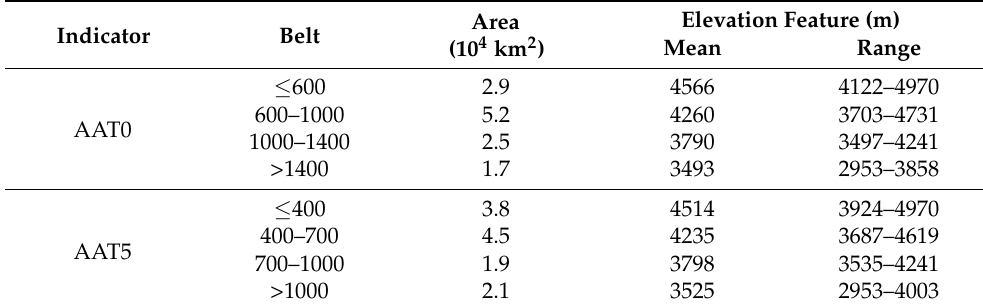
Figure 2. The distribution of the averaged ≥ 0 °C ( a ) and ≥ 5 °C ( b ) annual accumulated temperature during 1979–2018 in the source region of the Yellow River. Table 3. The area and elevation features of the four belts in the AAT.